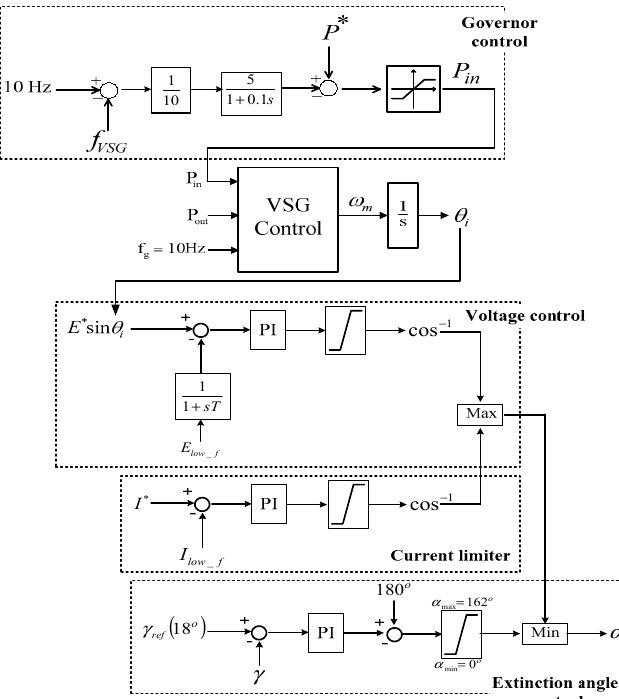
Figure 14. Complete control scheme of multi-terminal LFAC.